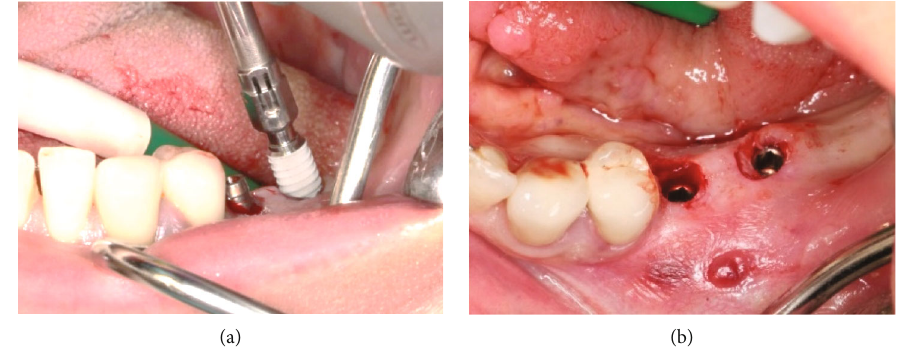
Figure 9: The implants were inserted in regions 35 and